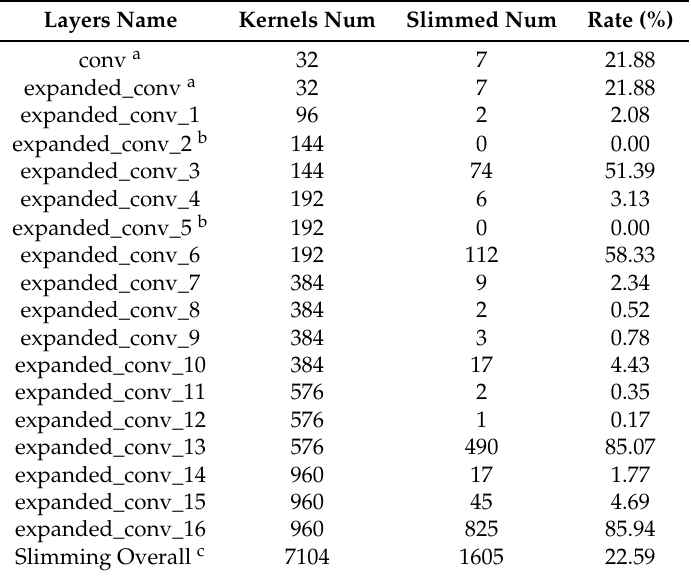
Table 1. Pruning and slimming information of our model.